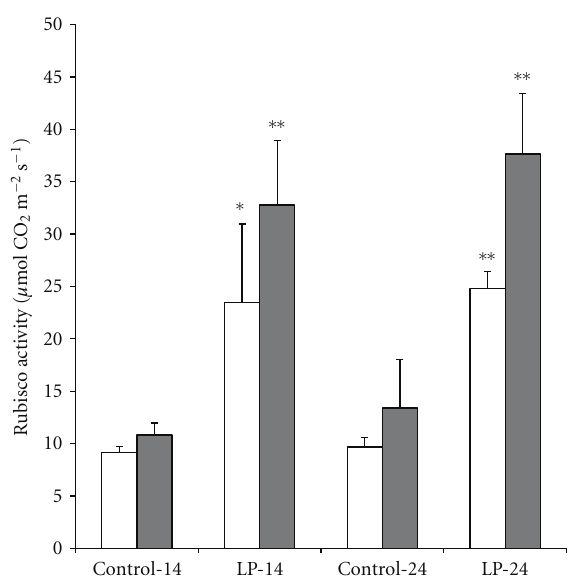
Figure 3: Initial and total activities of Rubisco in leaf extract from soybean plants grown with original pots (Control) and with larger pots (LP). Summary of growth conditions is described in Figure 1. Open bar, initial activity; closed bar, total activity. Vertical bars, S.D. ( n = 3). ∗ P < 0 . 05/ ∗∗ P < 0 . 01 ( t -test) when compared with control.